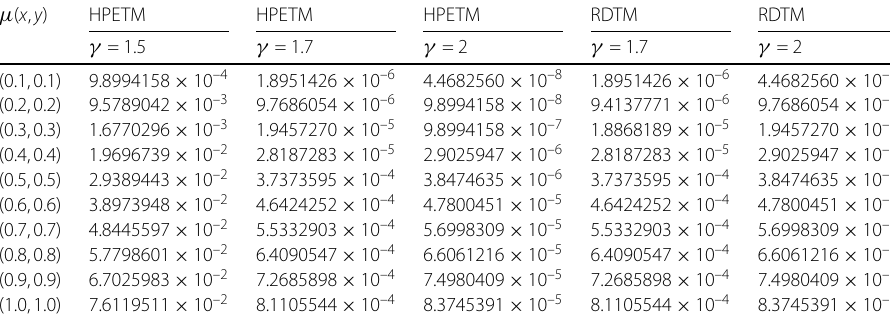
Table 1 Comparison of HPETM and RDTM solutions of different fractional-order results at γ of Example